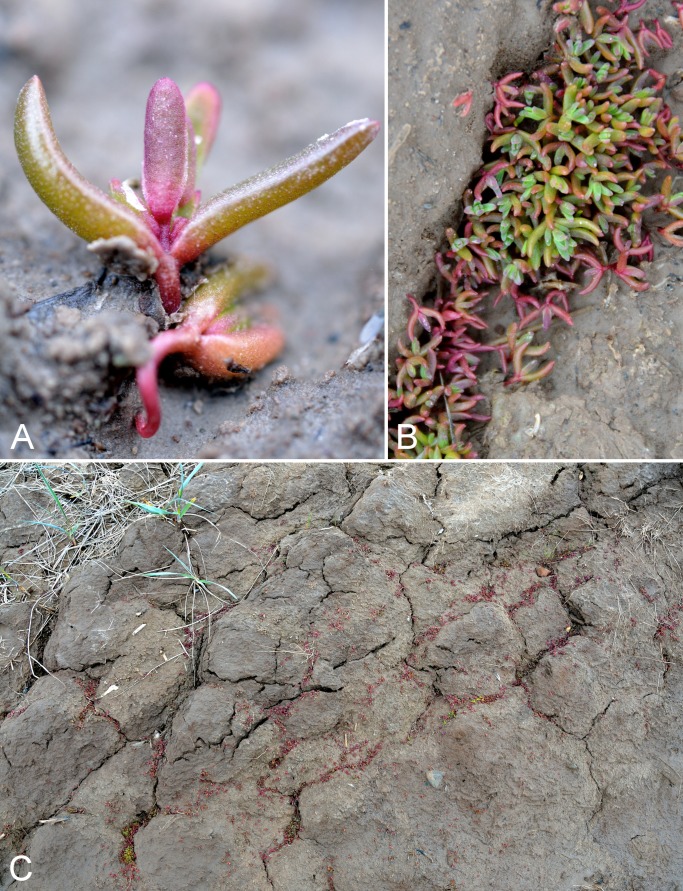
Suaeda calceoliformis.(A) Habit, Saarela et al. 3668. (B) Habit, Saarela et al. 3668. (C) Habitat, Saarela et al. 3668. Photographs by R. D. Bull.